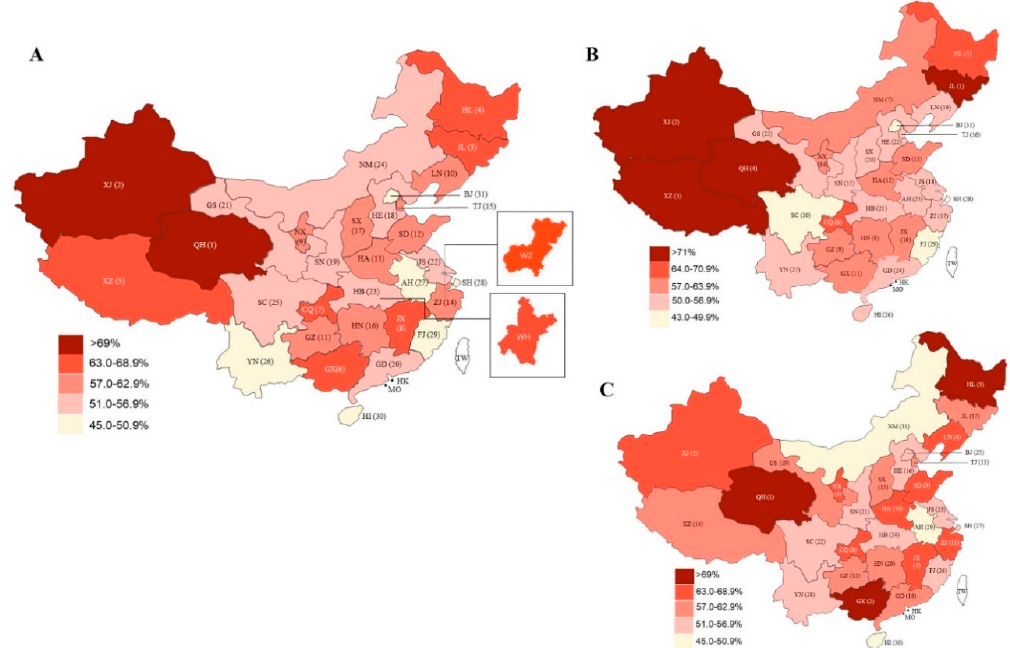
Figure 2. Provincial proportions of insufficient physical activity during home quarantine induced by COVID-19 for 31 provinces in mainland China. A: both sexes; B: men; C: women. BJ = Beijing. TJ = Tianjin. HE = Hebei. SX = Shanxi. NM = Inner Mongolia. LN = Liaoning. JL = Jilin. HL = Heilongjiang. SH = Shanghai. JS = Jiangsu. ZJ = Zhejiang. AH = Anhui. FJ = Fujian. JX = Jiangxi. SD = Shandong. HA = Henan. HB = Hubei. HN = Hunan. GD = Guangdong. GX = Guangxi. HI = Hainan. CQ = Chongqing. SC = Sichuan. GZ = Guizhou. YN = Yunnan. XZ = Tibet. SN = Shaanxi. GS = Gansu. QH = Qinghai. NX = Ningxia. XJ = Xinjiang. TW = Taiwan. HK = Hong Kong. MO = Macao. WH = Wuhan. WZ = Wenzhou.